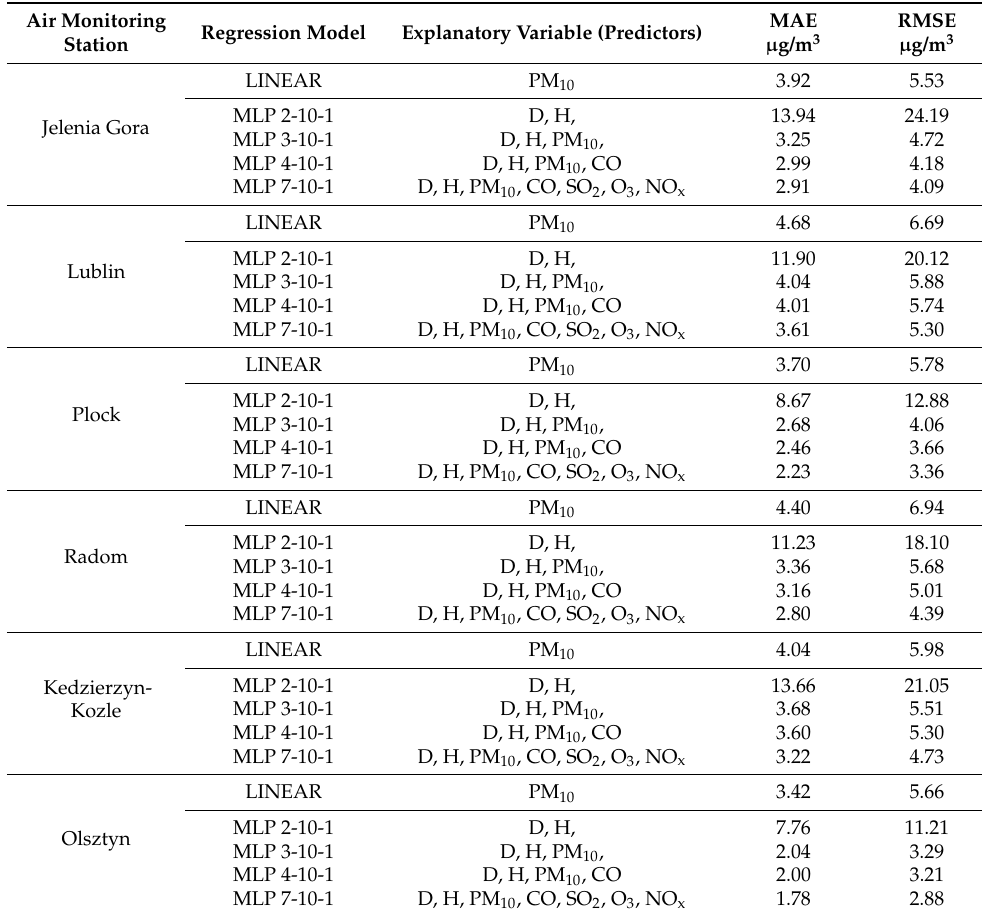
Table 5. Values of approximation errors of PM 2.5 concentrations in MLP models for 4 variants with different numbers of predictors. For comparison, the results for linear regression models, called LINEAR, were